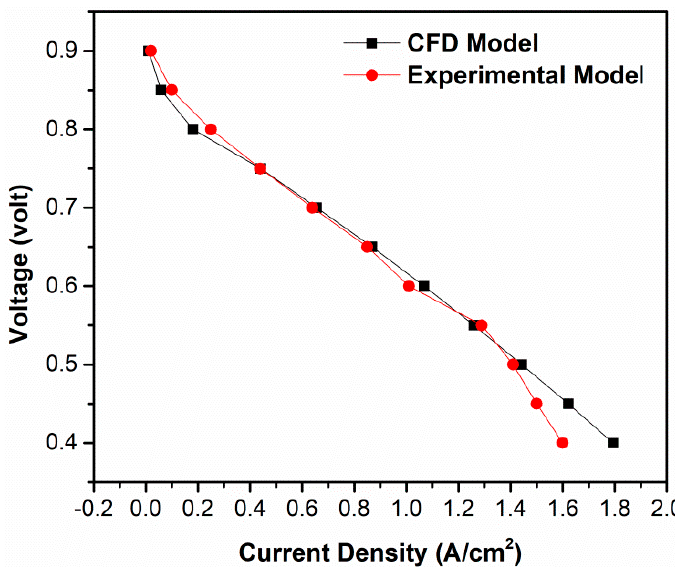
Figure 2. Polarization curves for CFD and experimental